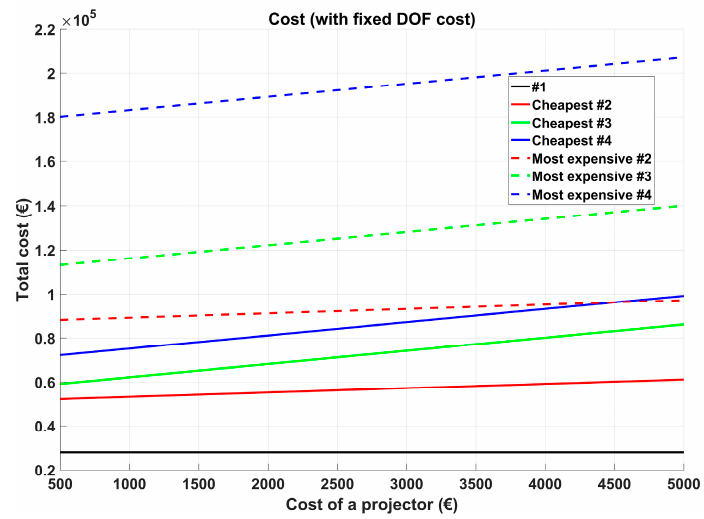
Figure 10. Cost comparison ( € ) with fixed C DM . Multimodal Technol. Interact. 2017 , 1 , 10